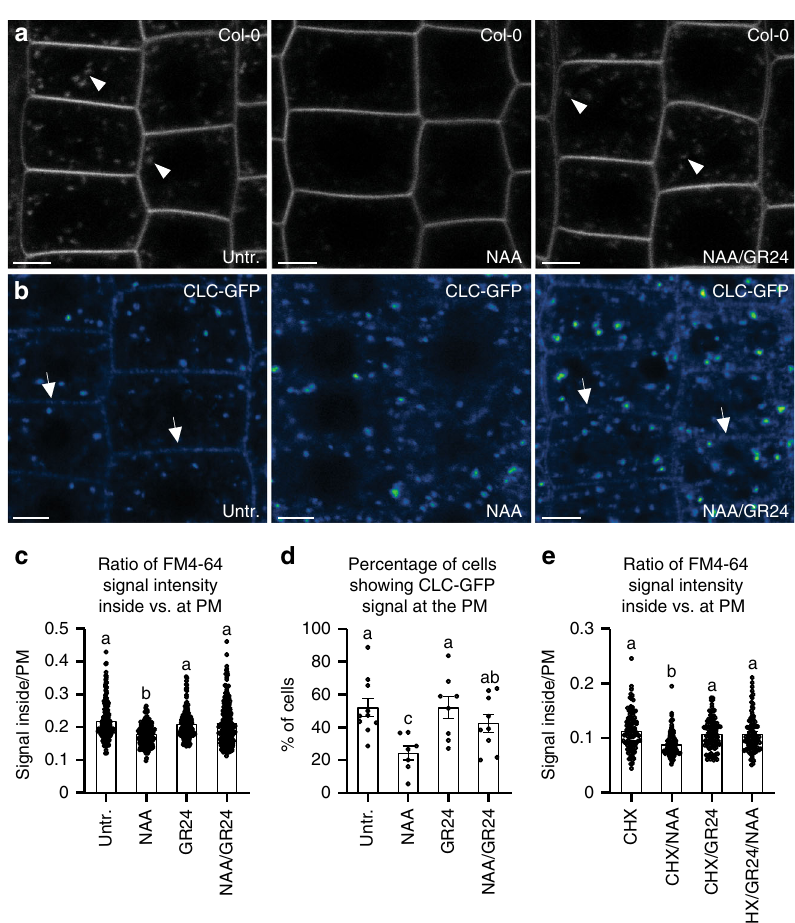
Fig. 4 Regulation of auxin-mediated inhibition on endocytosis by SLs in Arabidopsis . a , c , e Effect of GR24 on NAA-inhibited FM4-64 uptake. GR24 (1 μ M), which alone had no detectable effect on FM4-64 uptake, largely diminished the NAA (10 μ M) action of inhibiting FM4-64 uptake ( a , c ). Quantitative evaluation of FM4-64 uptake: the quotient between mean fl uorescence intensity of the intracellular and PM in the roots was scored ( c n ≥ 150 cells). GR24 treatment also effectively attenuated NAA-mediated inhibition of FM4-64 uptake, when protein synthesis was inhibited by 50 μ M cycloheximide (CHX; e n ≥ 91 cells). Arrowheads indicate endosomal compartments of FM4-64. Scale bars: 5 µ m. Data are expressed as mean ± s.e.m. Means with different letters are signi fi cantly different at P < 0.05 (one-way ANOVA with Fisher LSD test). b , d Effect of GR24 on NAA-regulated clathrin localization. CLC-GFP distributed at the trans-Golgi network and the PM. NAA (30 μ M) treatment induced a transient decrease of the CLC-GFP signal at the PM. GR24 (10 μ M), which alone had no detectable effect on CLC-GFP signal, largely prevented NAA action on depletion of CLC-GFP signal from the PM. The percentage of root cells showing CLC-GFP labeling at the PM was scored ( d n ≥ 7 roots). Arrows indicate CLC-GFP distribution at the PM. Scale bars: 5 µ m. Data are expressed as mean ± s.e.m. Means with different letters are signi fi cantly different at P < 0.05 (one-way ANOVA with Fisher LSD test). The above experiments were repeated three times with similar results. Images shown are representative of each treatment. Source data of c – e are provided in the Source data fi